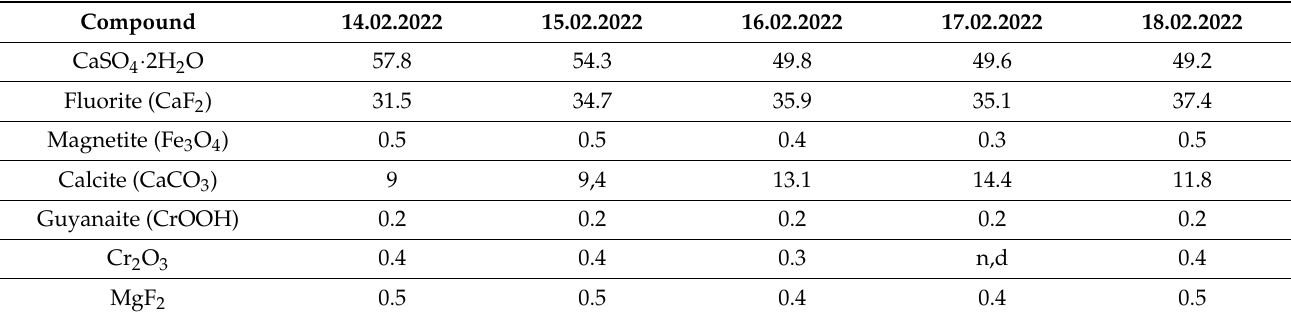
Figure 3. Diffractograms of the five samples dried at 60 °C with overlapping of the same. ( a ) Sam- ple from 14-02-2022, ( b ) Sample from 15-02-2022, ( c ) Sample from 16-02-2022, ( d ) Sample from 17- 02-2022, ( e ) Sample from 18-02-2022, ( f ) Overlapping of the previous diffractograms with identifi- cation of the main peaks.